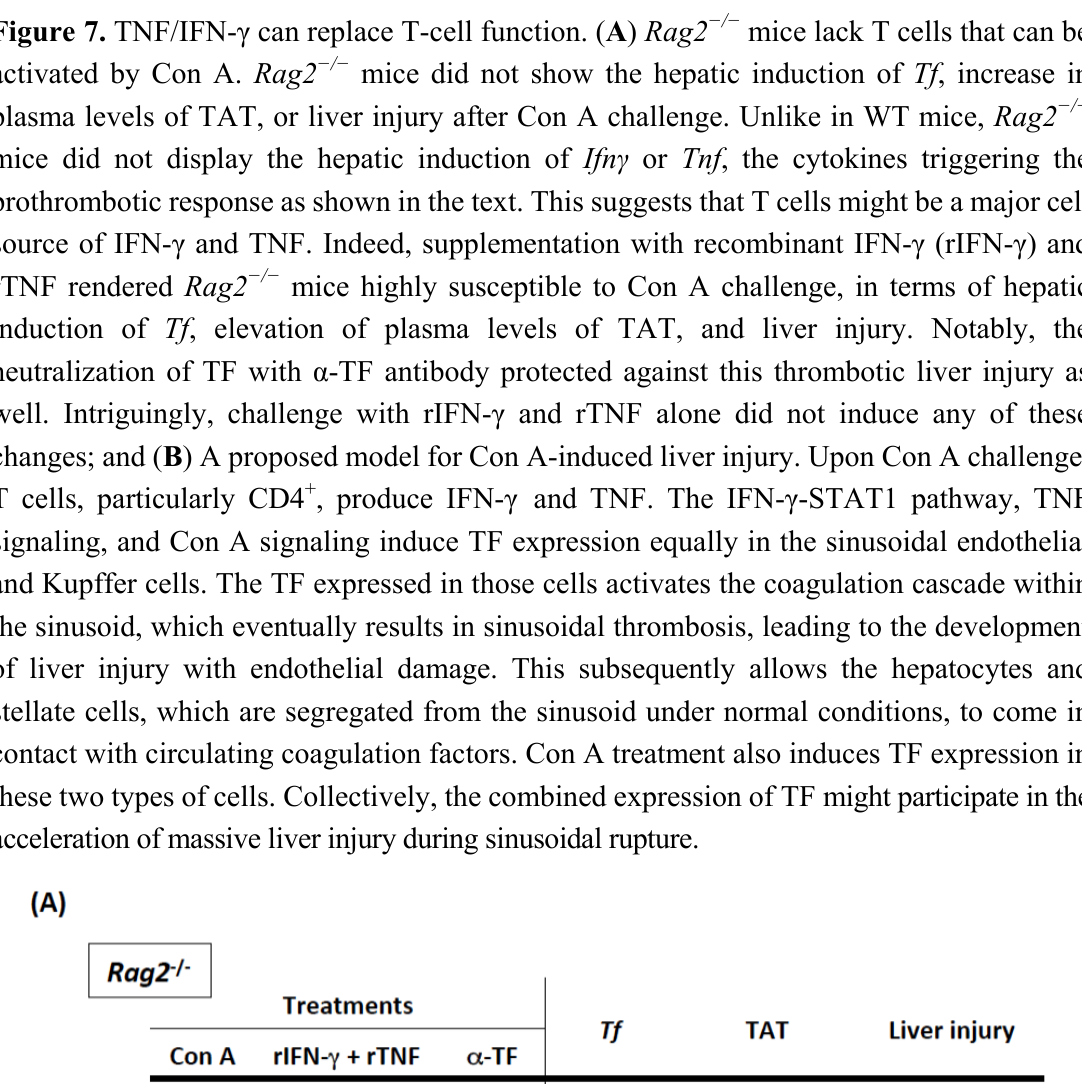
Figure 7. TNF/IFN- γ can replace T-cell function. ( A ) Rag2 − / − mice lack T cells that can be activated by Con A. Rag2 − / − mice did not show the hepatic induction of Tf , increase